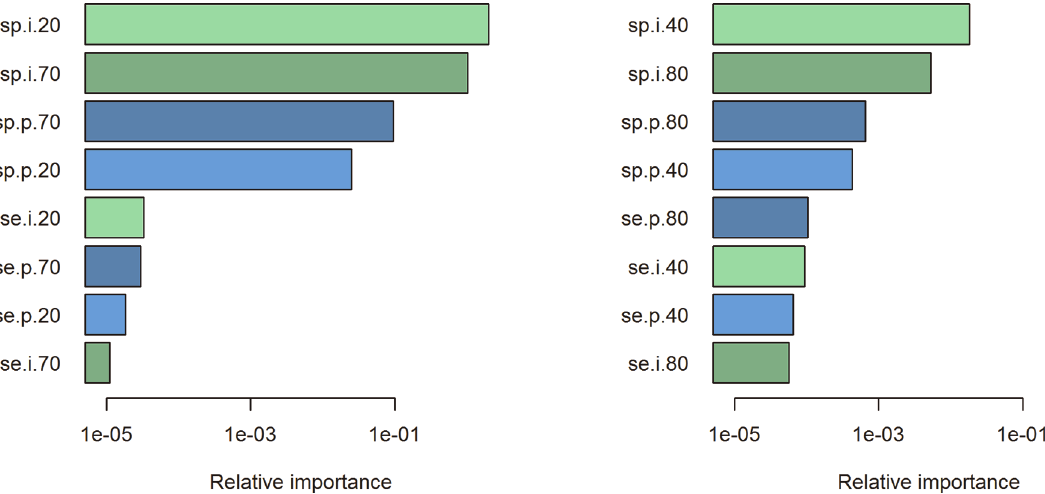
Figure3.Tornadoplotsforrelativeimportanceofthesensitivityandspecificity. Inbothsettings,low(leftpanel) andhighprevalence(right),thespecificities(prefixsp)arethefourdominanterrorfactorsinestimatingthemortality rate ratio R. Compared to specificities, sensitivities (prefix se) have a low impact on the error in